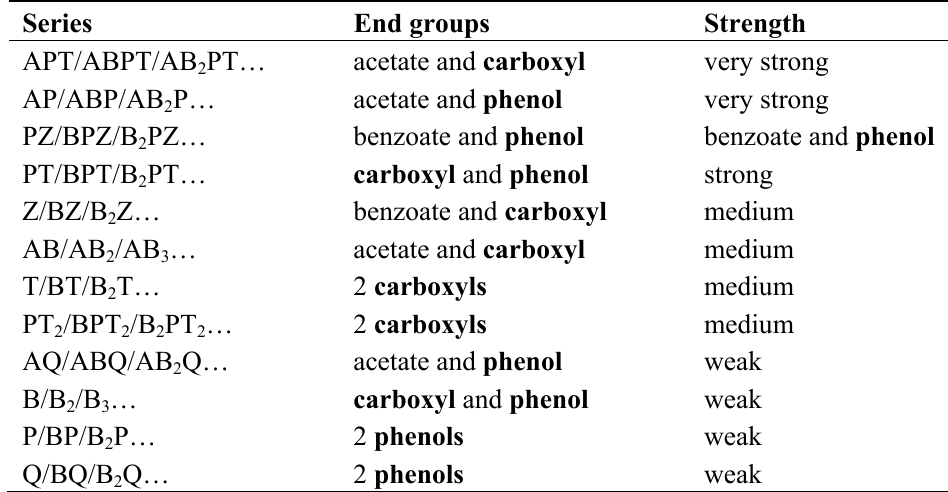
Table 6. End groups in observed oligomers from ESI − mass spectra; carboxyl and phenol end groups are in